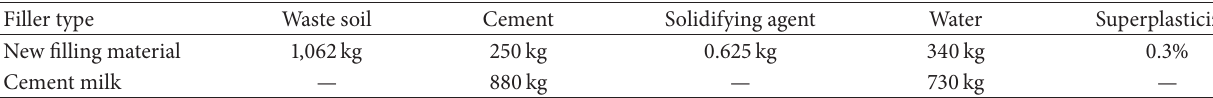
Table 1: Mix proportion [per 1m 3 ].